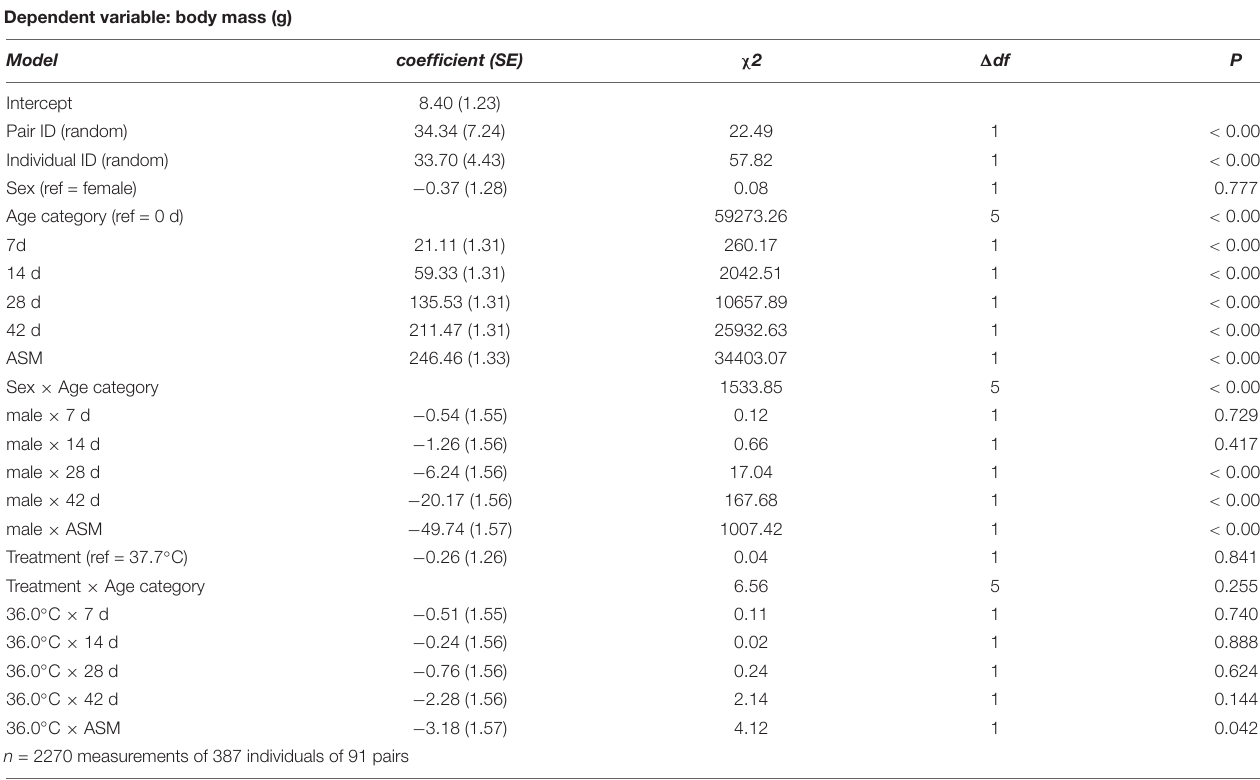
TABLE 1 | Summary of a linear mixed model testing for effects of incubation treatment on age- and sex-specific body mass in Japanese quail